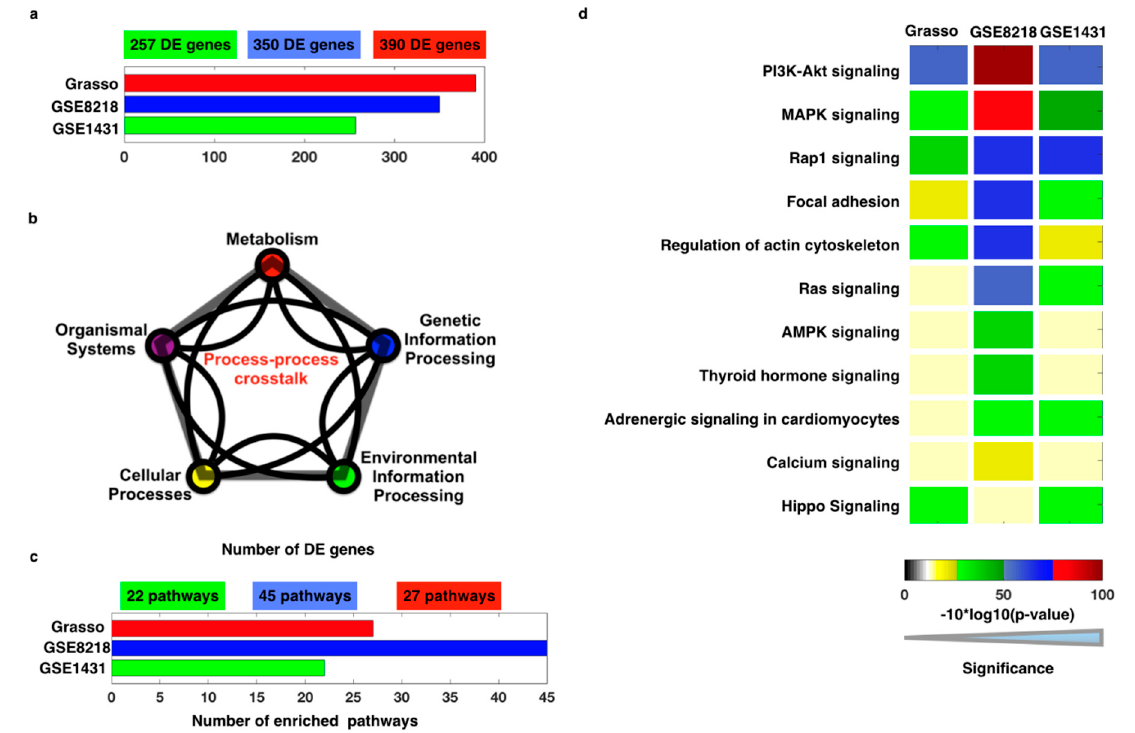
Figure 3. GECIP pathway analysis: ( a ) total number of DEGs for three different datasets of prostate cancer, ( b ) pathways selected from different KEGG pathway classes, ( c ) total number of enriched KEGG pathways for three different datasets of prostate cancer, ( d ) p -values (the heat map has been plotted by converting p -values into − 10 ∗ log10 of p -values (red: lowest p -value and gray: higher p -values and less than 0.05)) of 11 common enriched pathways.